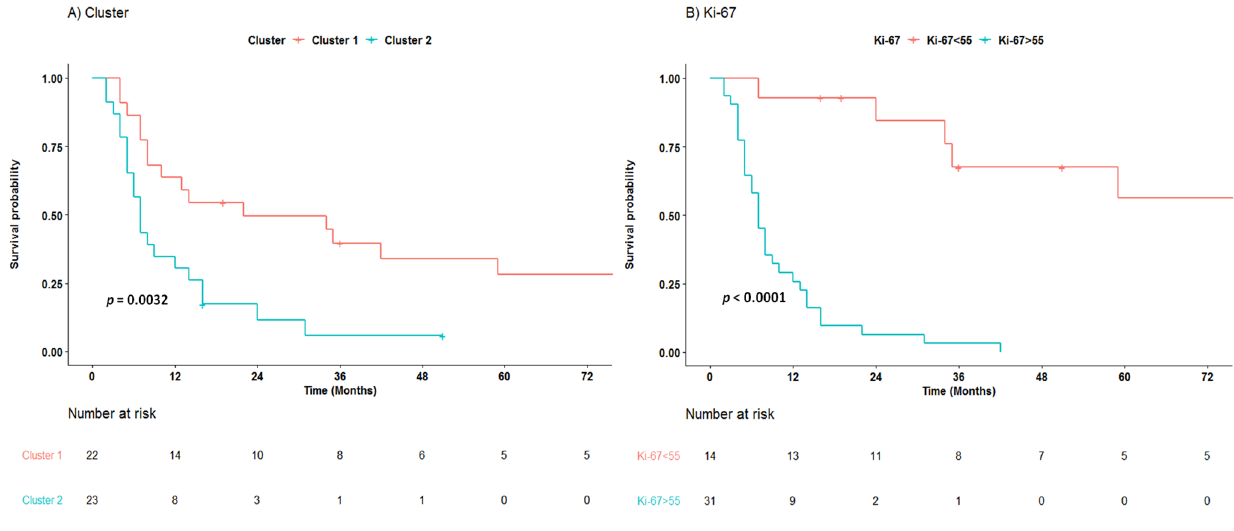
Figure 4. Cancer-specific survival of patients with high-grade neuroendocrine neoplasms according cluster ( A ) and Ki-67 55% cut off ( B ).